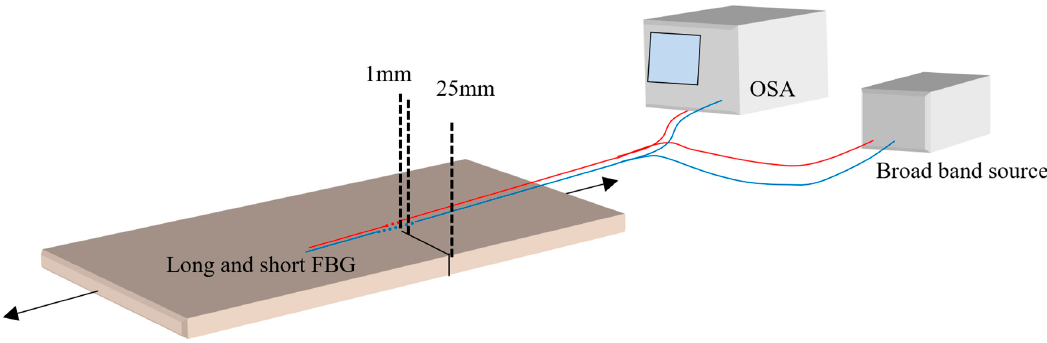
Figure 2. Aluminum coupon with short and long FBGs.